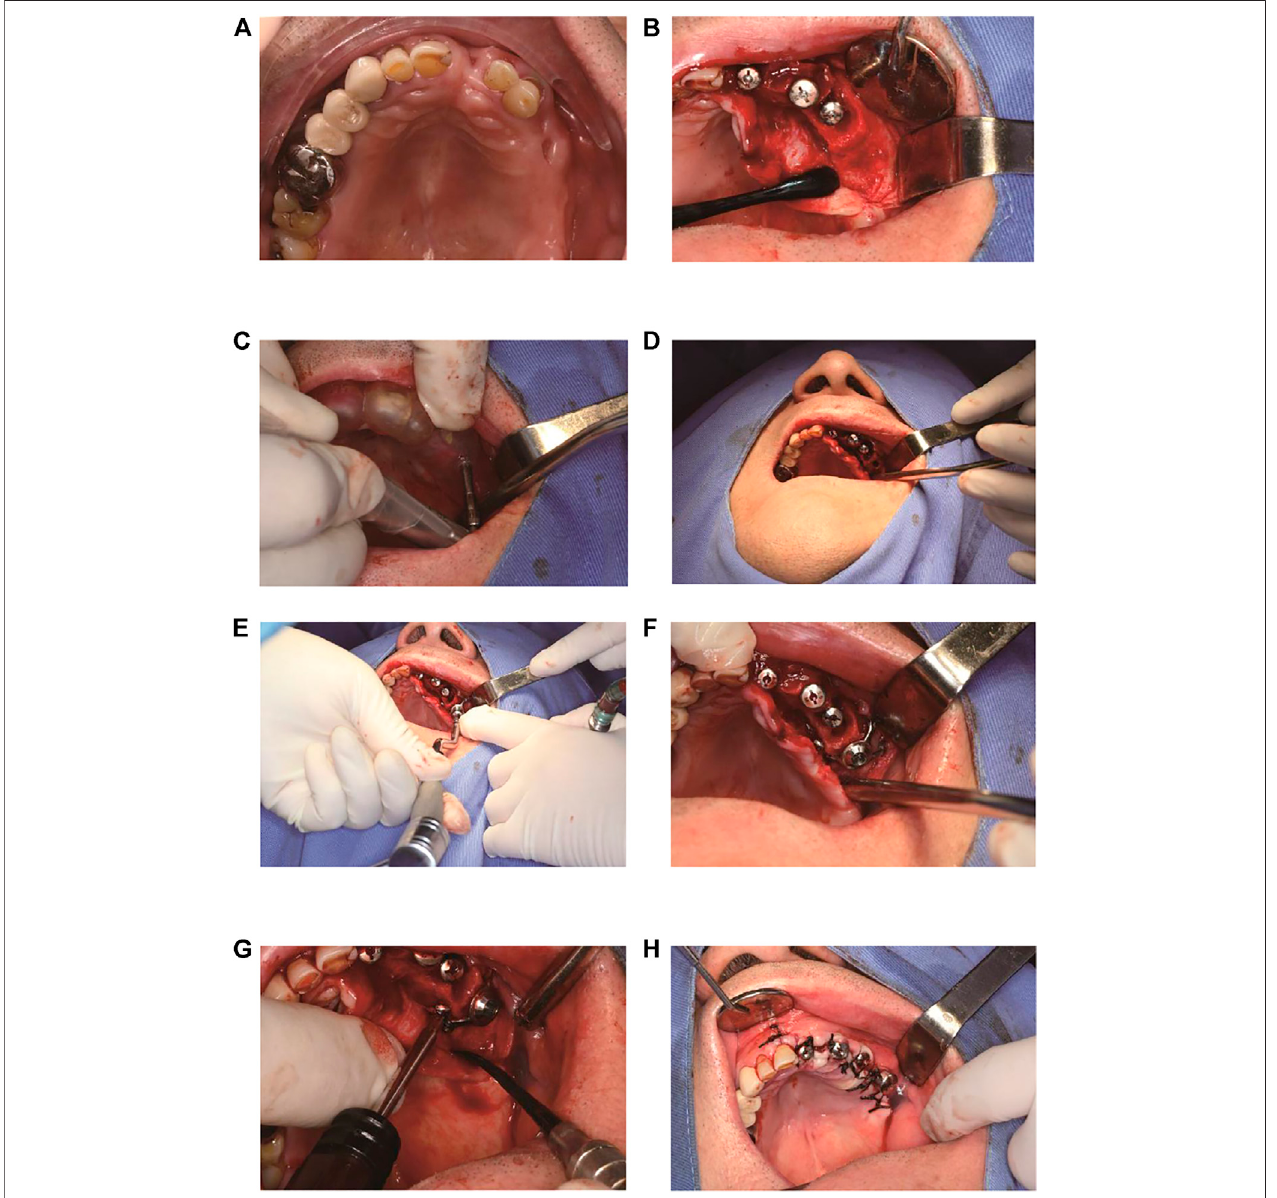
FIGURE 5 | The brief surgical procedure. (A) Preoperative intraoral view. (B) Anatomy of the residual bone. (C) Location of the implant by implant guide template. (D) Thecon fi rmationofimplantsocketdirectionanddepth. (E) Placementoftheimplant. (F) Theimplantisinposition. (G) Fixationwithseveralmini-screws. (H) Sutures.